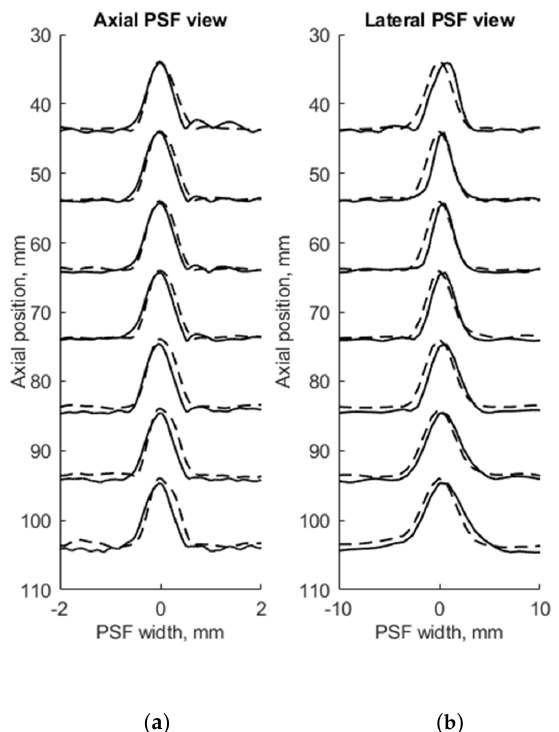
Figure 5. Comparison of axial ( a ) and lateral ( b ) width of PSF: solid line—experimental echoscopy of physical wire phantom, dashed line—simulation of wire phantom by point scatterers. PSF amplitudes were normalized from 0 to